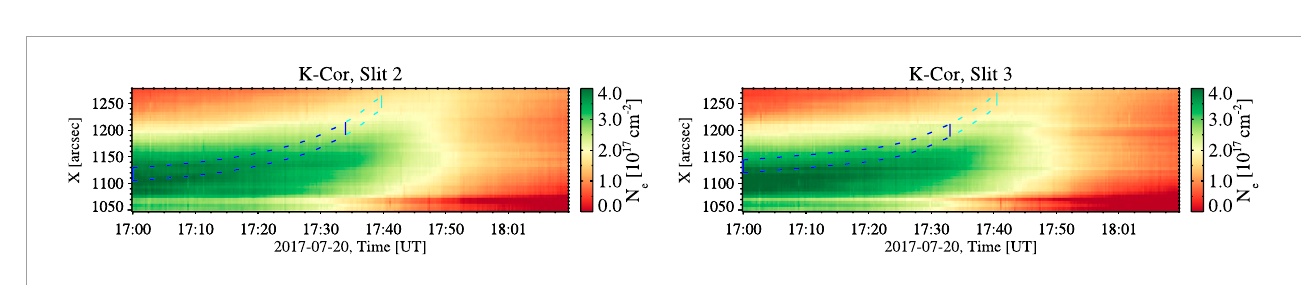
FIGURE 9 The column electron density space-time maps. The blue and the cyan curves are the same as in Figure 6 .